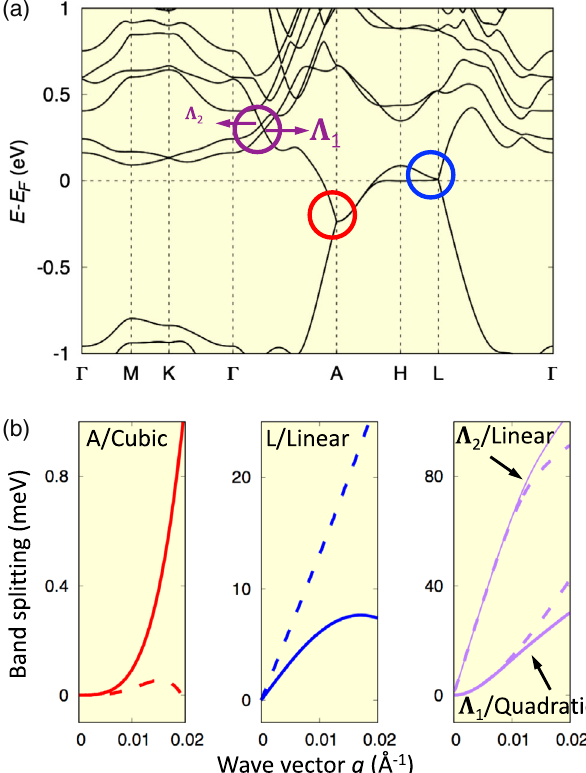
FIG. 2. (a) DFT calculated band structure of Tl ð MoTe Þ 3 as a representative of stable A ð MoX Þ 3 compounds. The different types of Dirac points are marked by red, blue, and purple circles. (b) In-plane band splitting in the vicinity of the four types of Dirac fermions at A, L, Λ 1 , and Λ 2 points. The solid (dashed) lines denote DFT band splitting along the k the coordinate system defined in Fig.